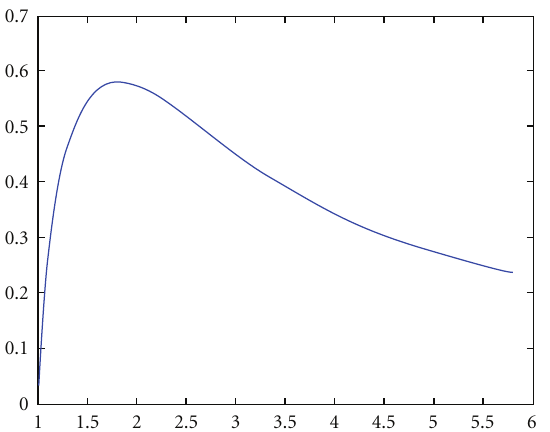
Figure 1: Curve of C ( β ) /β , where G ( x ) is the expected cost of the input symbol.